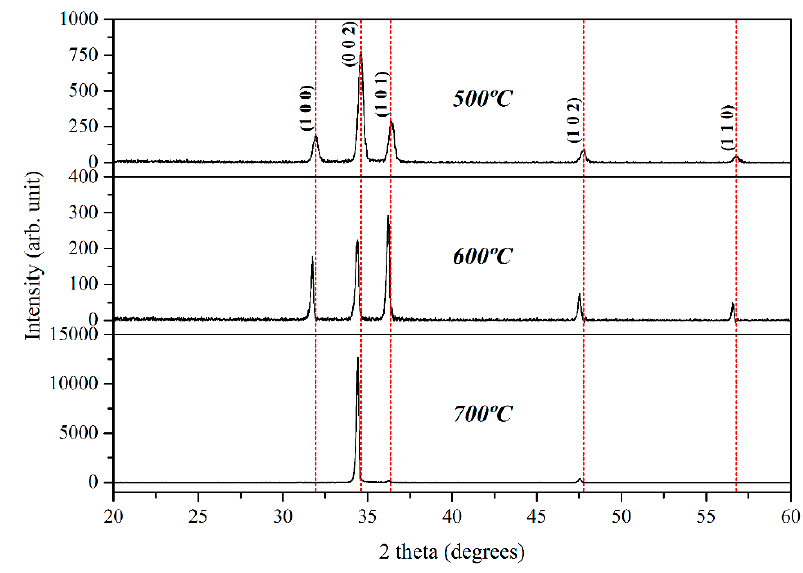
Figure 1. XRD patterns of as-deposited ZnO prepared at different growth temperatures.